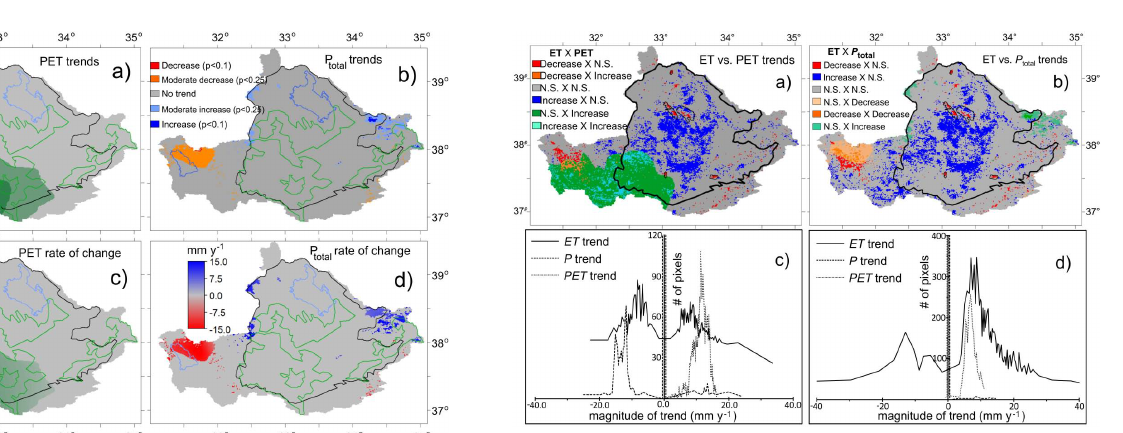
Fig. 12. (a) The distribution and direction of PET trends, (b) the dis- tribution and direction of P trends (c) the magnitude of PET trends, (d) the magnitude of P trends. The black polygon shows the water- limited part, the green polygons indicate the irrigated croplands and the blue polygons the lakes.